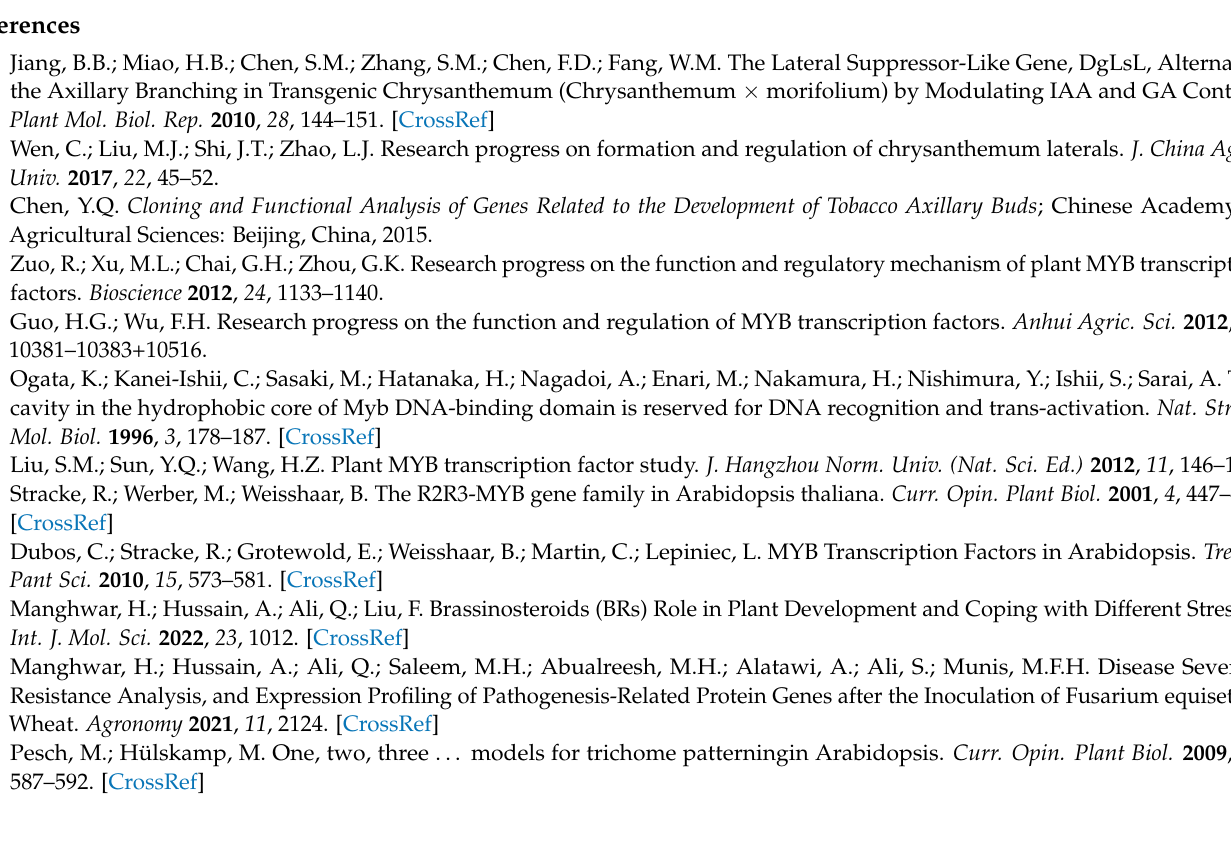
PCR system; Table S2: PCR reaction program; Table S3: Genome DNA removal; Table S4: